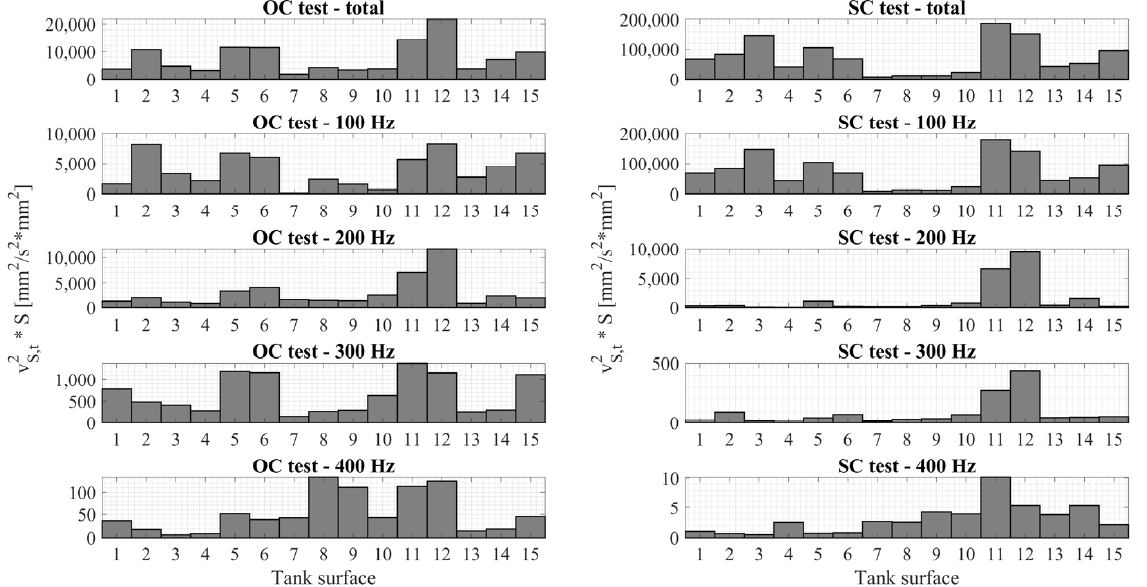
Figure 12. Space and time-averaged mean square vibration velocity of the plate multiplied with surface area for 15 measured transformer surfaces marked in Figure 2b.